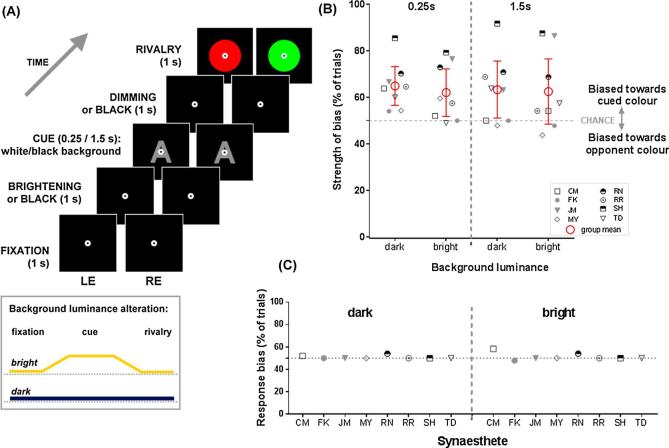
Experiment 3: the effect of background luminance on the synaesthetic priming effect.(A) time-line of trial events of the bright and dark conditions (not to scale; see text for details). The alteration of background luminance over trial timeframe is illustrated in the lower box. (B) Data from 8 synaesthetes showing the strength of perceptual bias of each condition, grouped by different durations of the cue and background luminance (dark, bright). Error bars represent 95% confidence intervals. (C) Each data point represents response bias for each individual in the mock-rivalry catch trials, plotted separately for the dark (left) and bright (right) backgrounds.